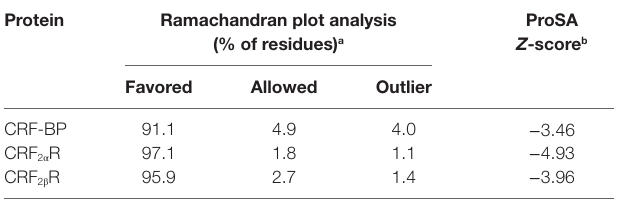
Prosa Z -score b